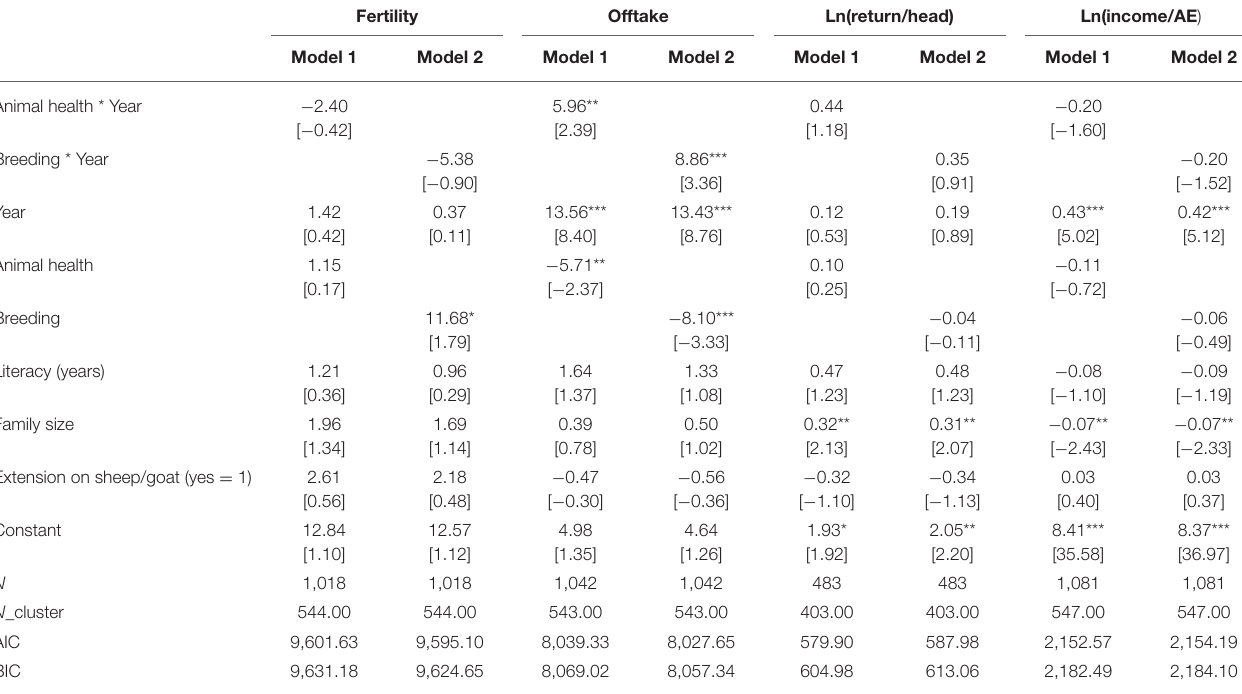
TABLE 6 | DiD with basic fixed-effects specification with covariates.